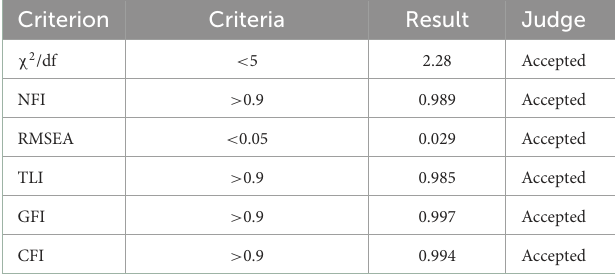
TABLE 5 The fitness of SEM.